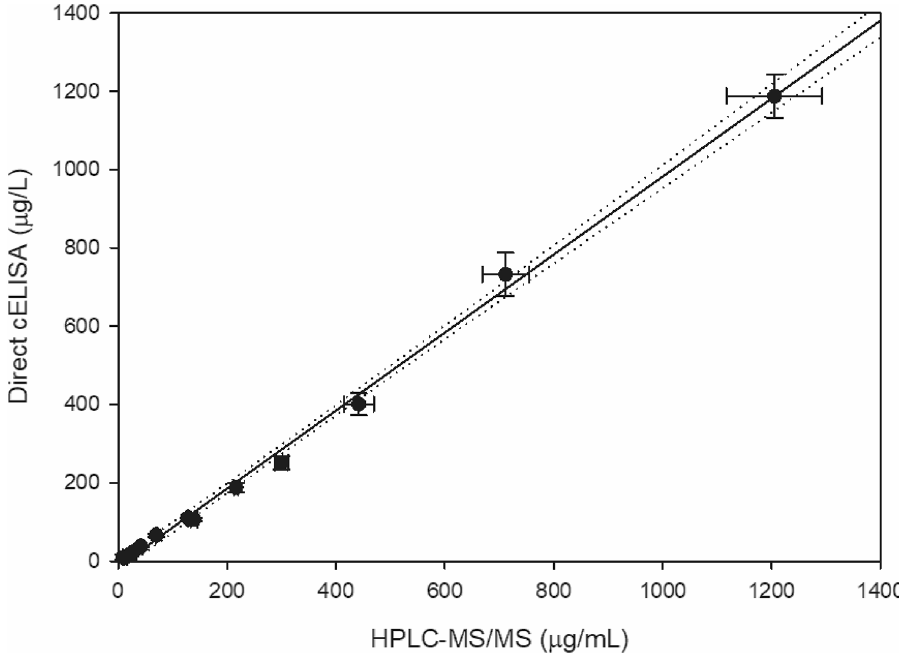
Figure 2. Comparison of results obtained by direct cELISA and HPLC ‒ MS/MS from contaminated grape